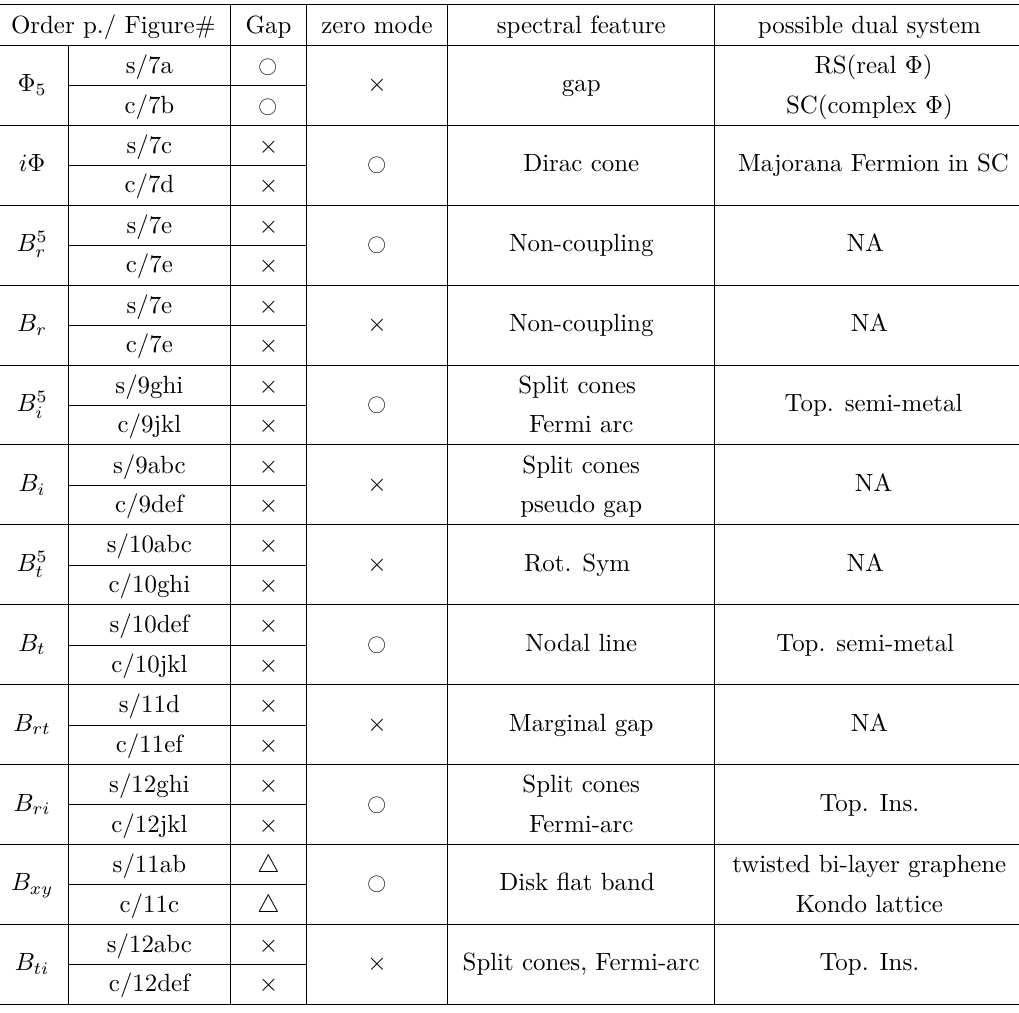
Top. Ins. c/12def × Table 1. In the table of “Gap”, denotes gap at the fermi-level, 4 represents gap off the fermi level and × is gapless. SC=superconductivity, RS=Random Singlet. A ( k x , ω ) means we consider # the spectral function A as the function of k x and ω . Under k x ↔ k y those with one spatial index are assymetric. All others are symmetric. NA=not